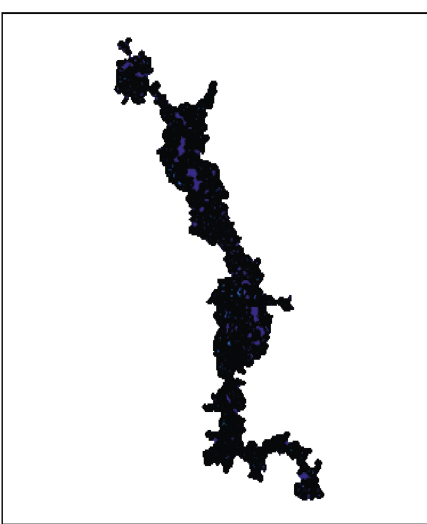
Figure 19: Contour plot of simulated water depth on January 8, 2017, used for the initial condition.